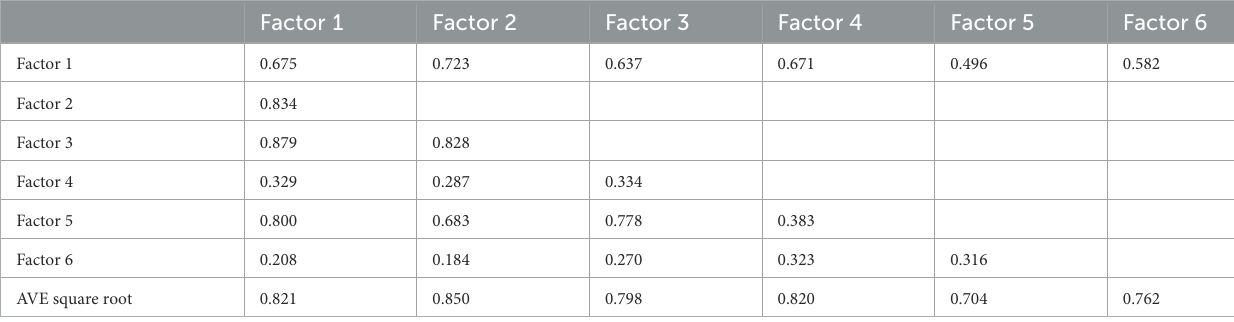
TABLE 4 Discriminant validity for SSc health literacy scale.